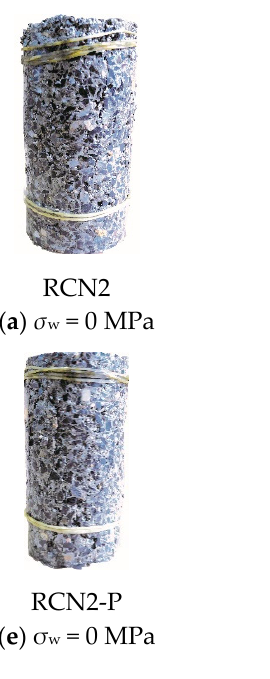
Figure 3. The failure mode of recycled concrete after compression.